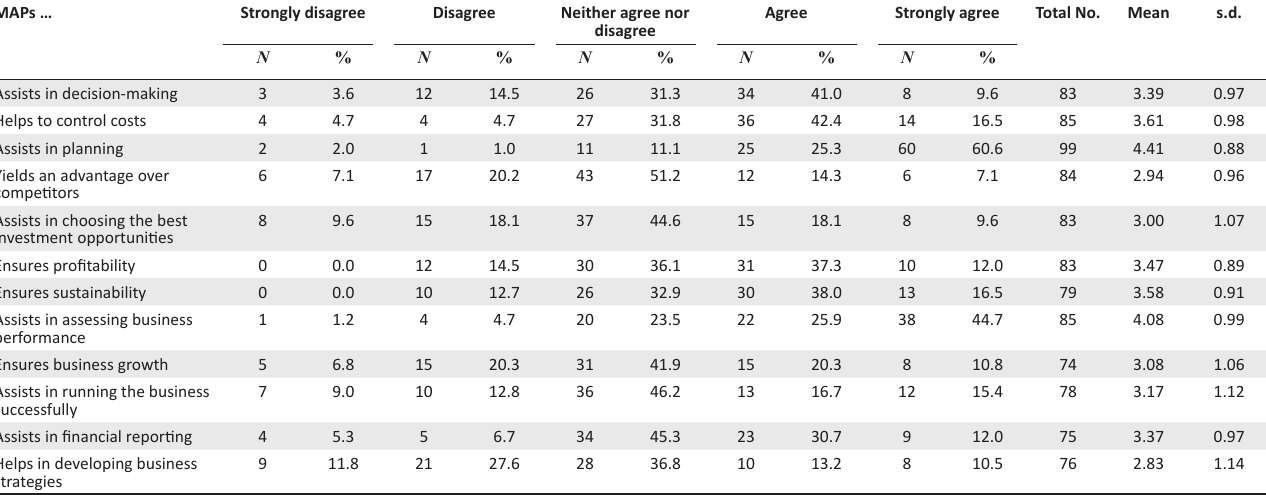
TABLE 5: Respondents’ use of management accounting practices. MAPs